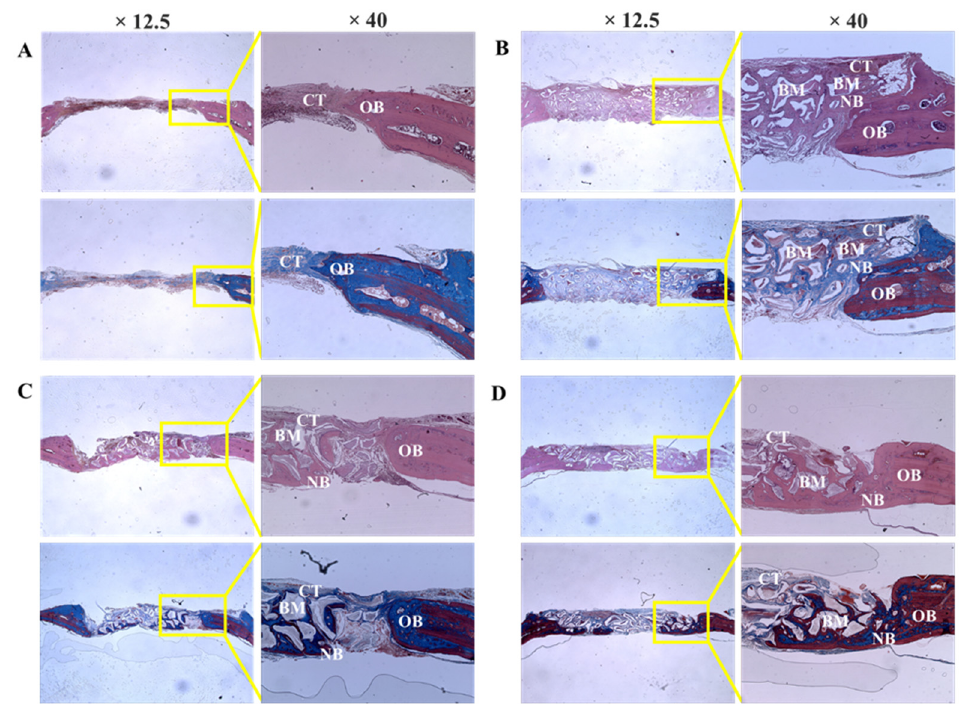
Figure 7. Histologic sections of defect sites at 8 weeks after surgery. ( A ) Control, ( B ) Bio-Oss, ( C ) Bone-XB, ( D ) S1-XB. Note: NB; new bone, CT; connective tissue, GM; graft materials, OB; old bone.